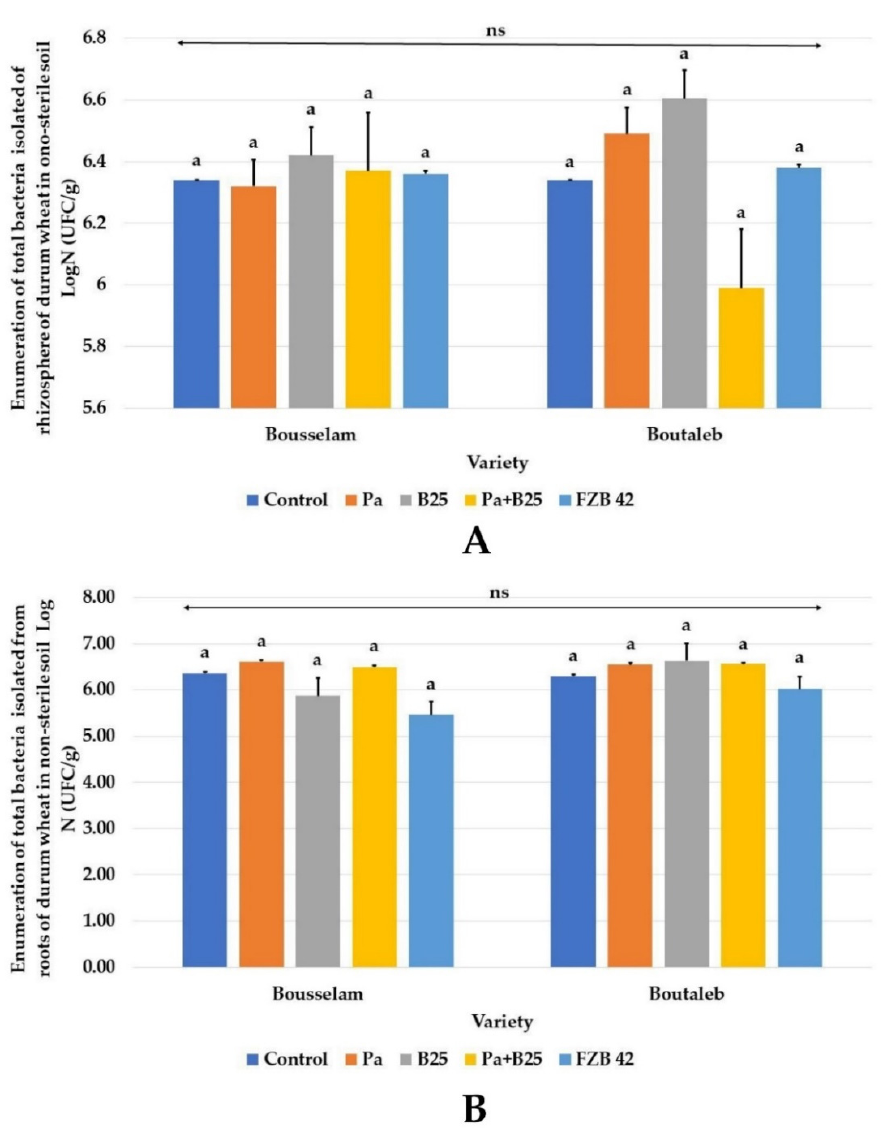
Figure 12. Enumeration of total bacteria isolates (Log N(CFU/g)) from ( A ) rhizosphere and ( B ) roots of wheat plants of Bousselam and Boutaleb varieties, grown in non-sterile soil inoculated with Pa, B25, Pa + B25 and FZB42. The bar plots represent the mean ± standard error of three different experiments. IBM SPSS Statistics v.24 was used to perform statistical analysis, using a two-way ANOVA and Tukey’s multiple comparison post-test. ns: non-significant.